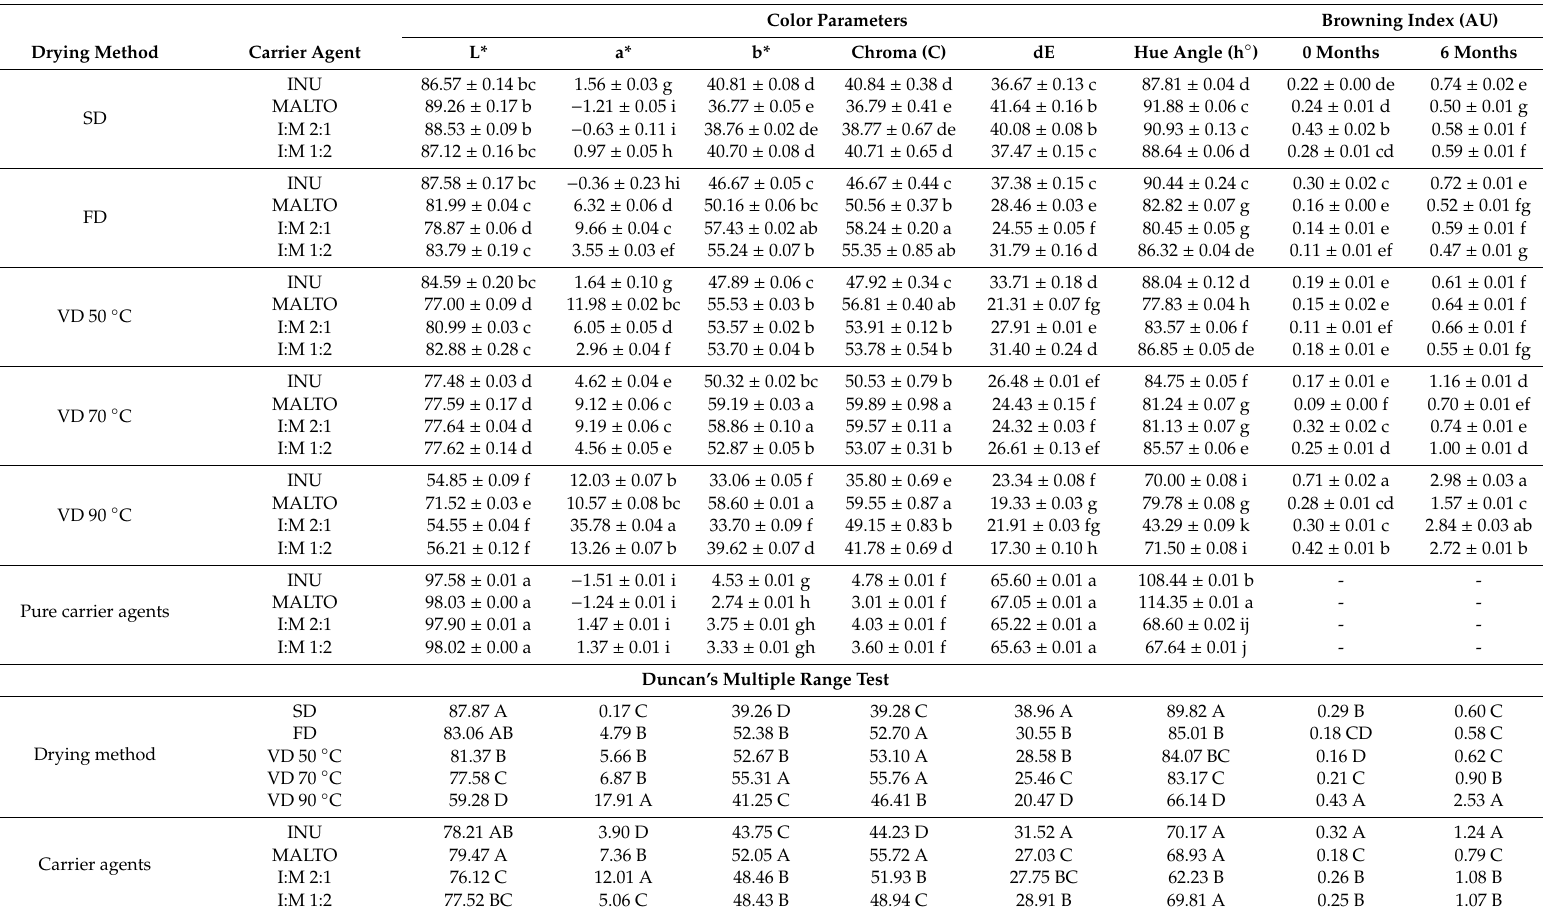
Table 2. Color parameters and browning index of sea buckthorn juice